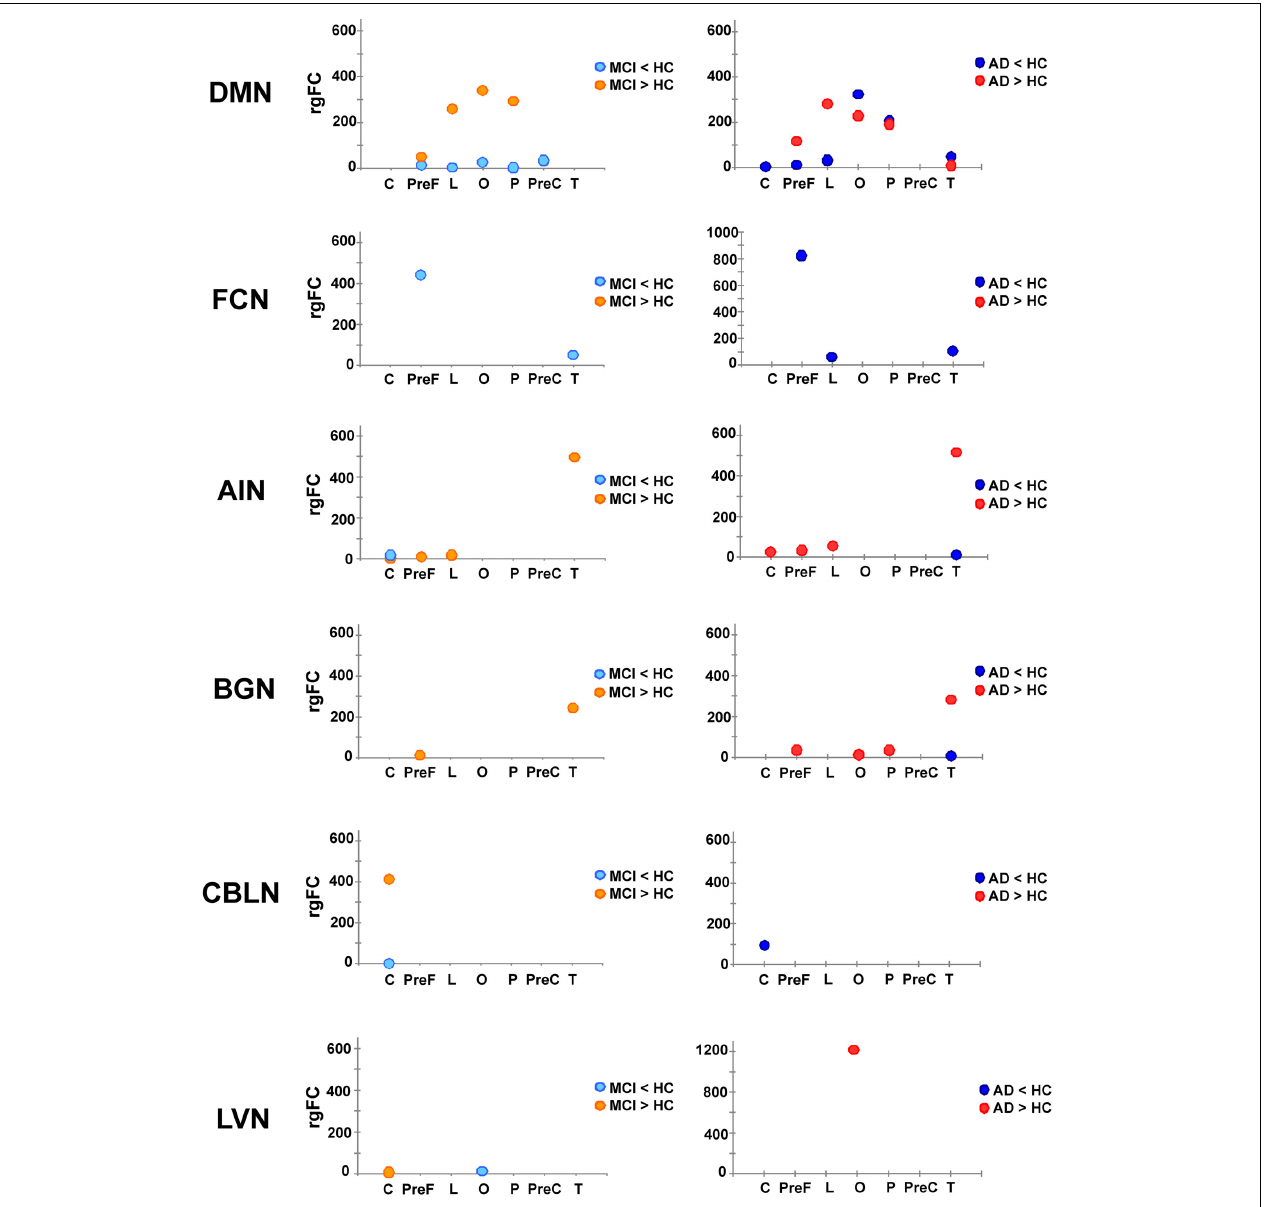
FIGURE 5 | Patterns of r gFC changes within specific RSNs. Pictures show the value of r gFC across conditions (MCI < HC and MCI > HC on the left side, AD < HC and AD > HC on the right one) for each sub-area of the brain: